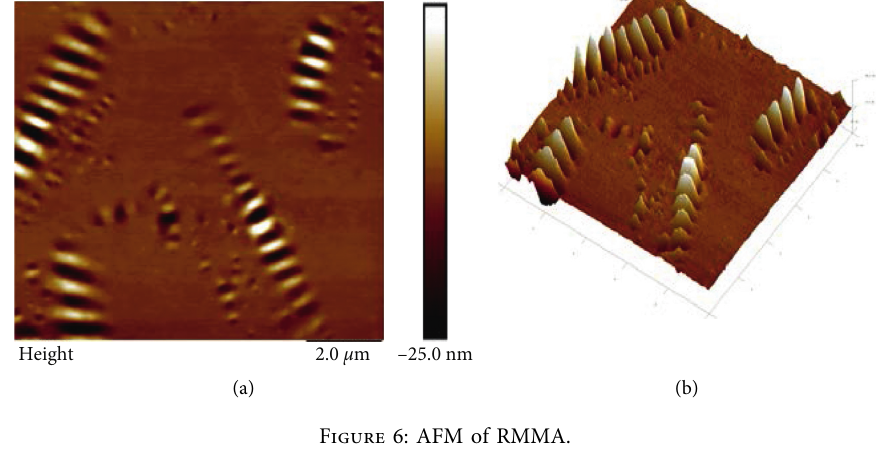
Figure 6: AFM of RMMA.